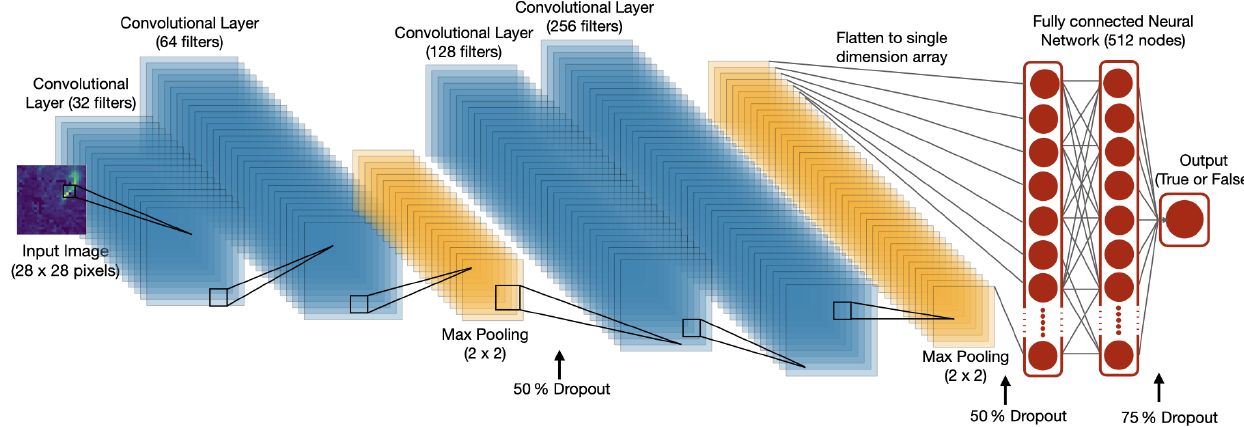
Figure 1. Simplified schematic of the convolutional neural network architecture to identify NO 2 plumes. See main text for further details.